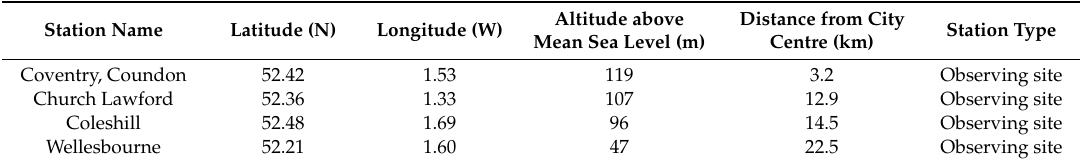
Table 1. Historical weather data for Coventry and its surrounding area, ranging between 1981 and 2010 [20].